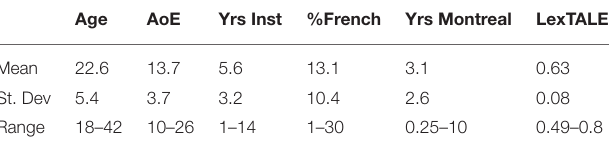
TABLE 3 | Non-native French